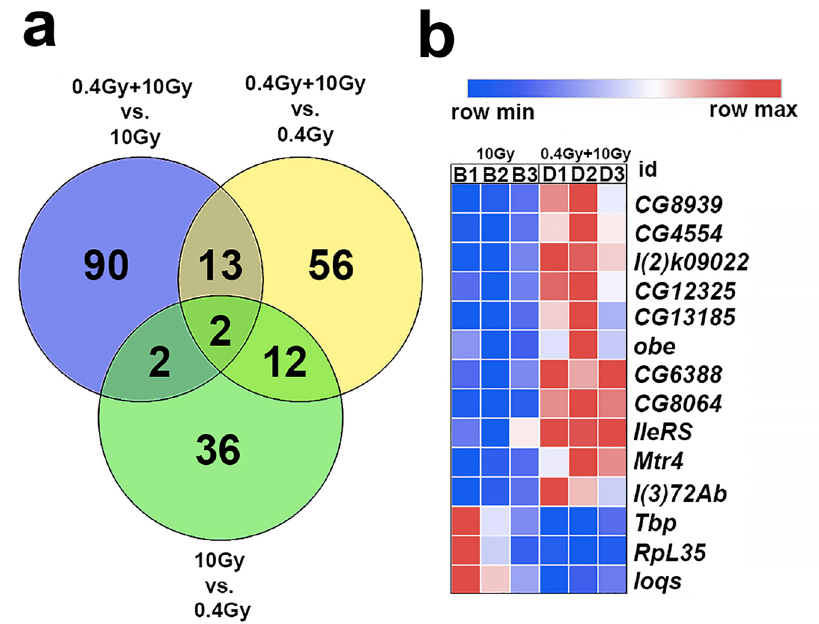
Fig. 5 Analysis of differentially expressed genes in radio adaptive response. a Representation of the Venn diagram including all differentially expressed genes from 0.4 Gy LDR + 10 Gy vs. 10 Gy, 0.4 Gy LDR + 10 Gy vs . 0.4 Gy LDR and 10 Gy vs . 0.4 Gy LDR comparisons. Only a very low percentage of genes were in common among all comparisons. A complete list of differentially expressed genes is provided in the Supplementary Data 2, 3 and 5. b Heat map representing the differentially expressed genes from 0.4 Gy LDR + 10 Gy vs . 10 Gy comparison belonging to “ RNA processing ” biological process obtained from DAVID functional enrichment analysis (Supplementary Data 6). The analysis was performed on three biological replicates obtained from three independent experiments, namely 1, 2, and 3 from the 10 Gy (B) and 0.4 Gy LDR + 10 Gy (D) conditions. A color-coded scale for the normalized expression values is used: red and blue represent high and low expression levels,